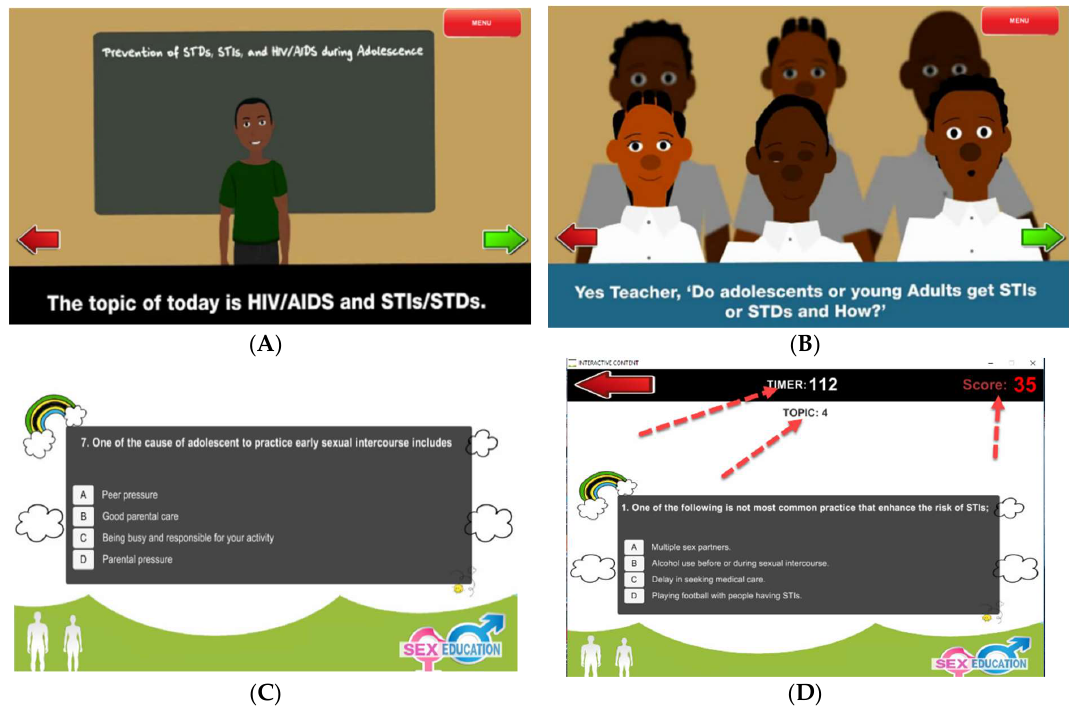
Figure 2. GBL condition game structure. ( A ) Scenario: teacher presenting the topic; ( B ) Scenario: students attending the class; ( C ) Questions; ( D ) Activity time, topic, and scores.